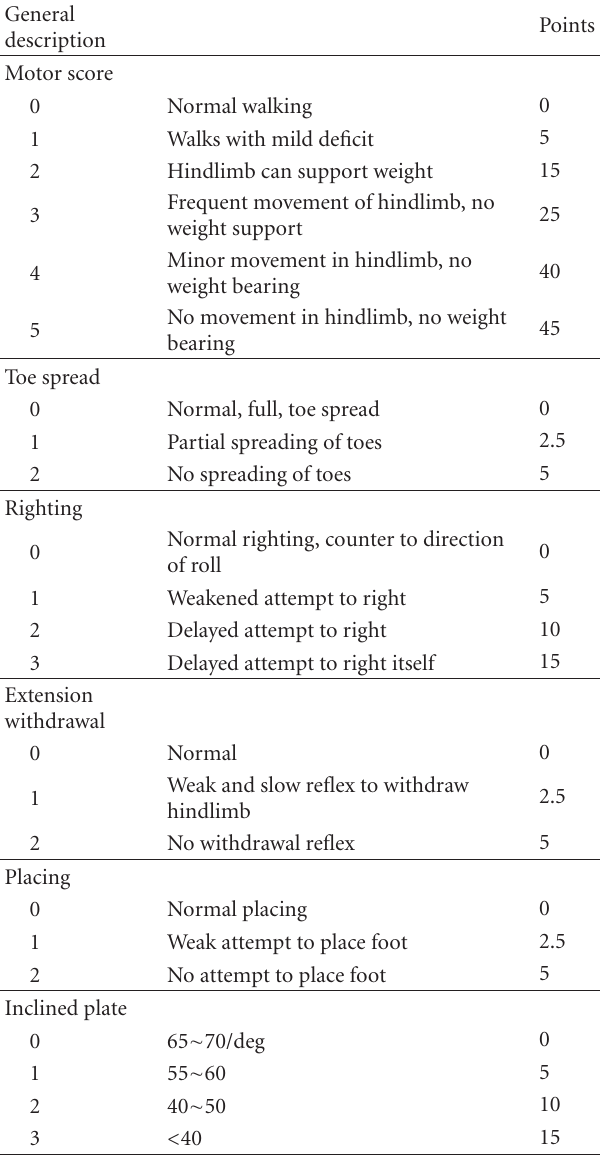
Table 4: Combined Behavioral Score (CBS), as reported by Gale et al.